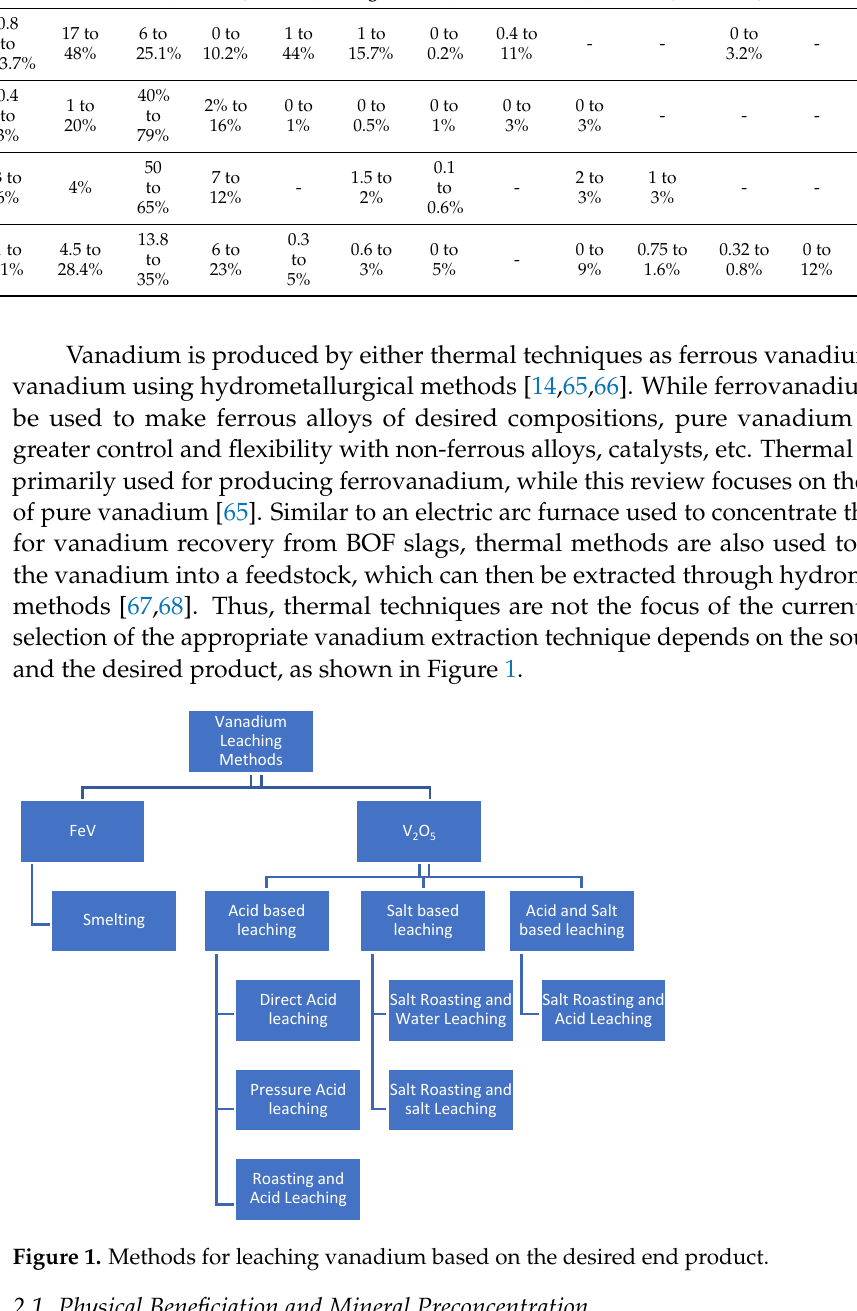
Table 1. Range of composition of major vanadium feedstocks.